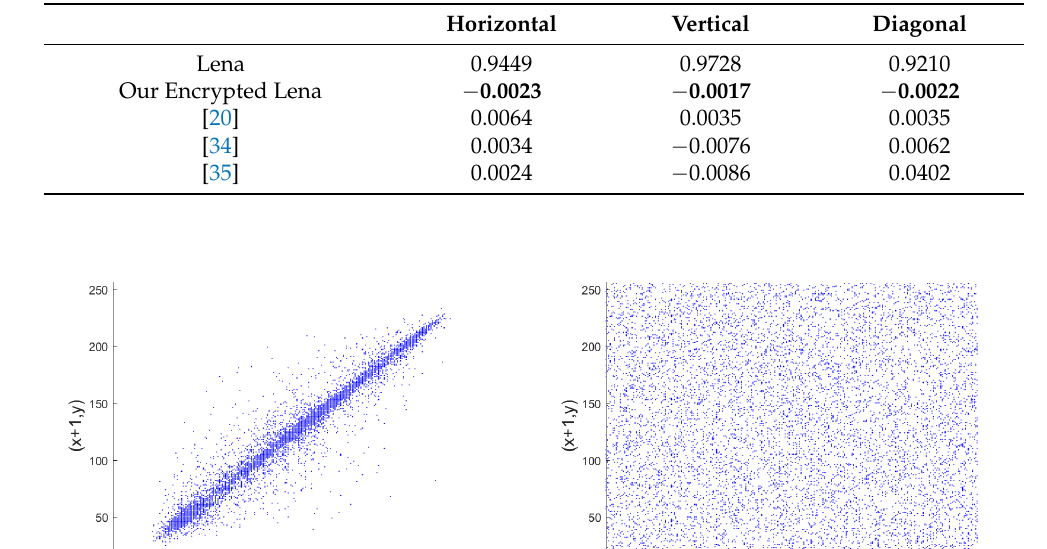
Table 2. Correlation coefficients of the Lena images encrypted with diverse schemes.